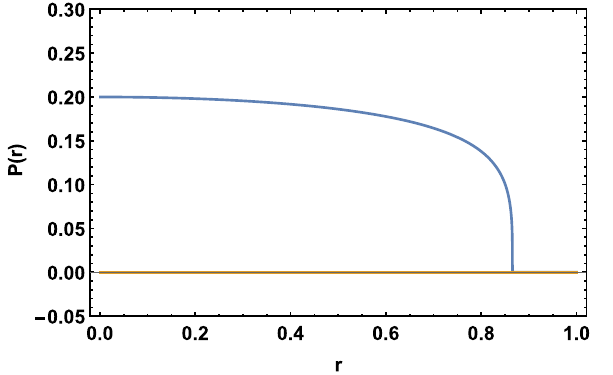
Fig. 4 The bottom curve is the radial dependence of the factors Z ( r ) P (cid:3) ( r ) associated to the integrand in (34), shown in a close vicinity of r b . It can be seen that in the limit r → r − this quantity is finite. b Therefore, the integration vanishes when the width 2 δ of the region approaches zero. This result verifies the satisfaction of the solvability condition. The plot at the top illustrates the values of the pressure P ( r ) which suddenly reduces to zero at r